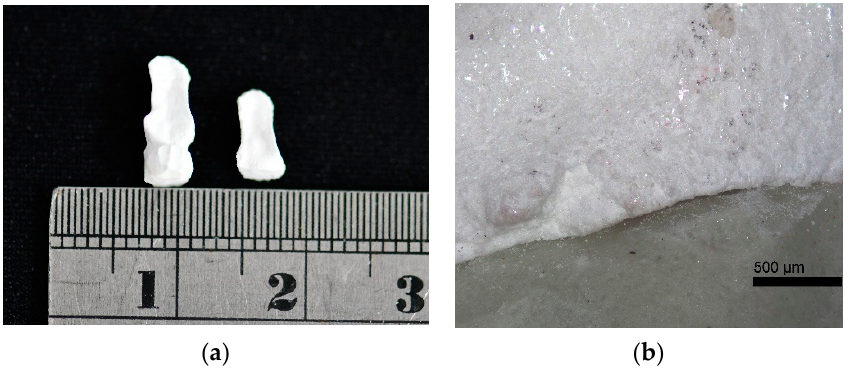
Figure 7. ( a ) OM image of samples sintered at 950 °C (right) and 1350 °C (left ) , showing the better marginal integrity at 1350 °C. ( b ) Marginal discrepancy of sample 7Z3N sintered at 1350 °C. Table 1. Marginal discrepancy of samples 7Z3N and 6Z4N sintered at 1350 °C for 4 h (N = 36).